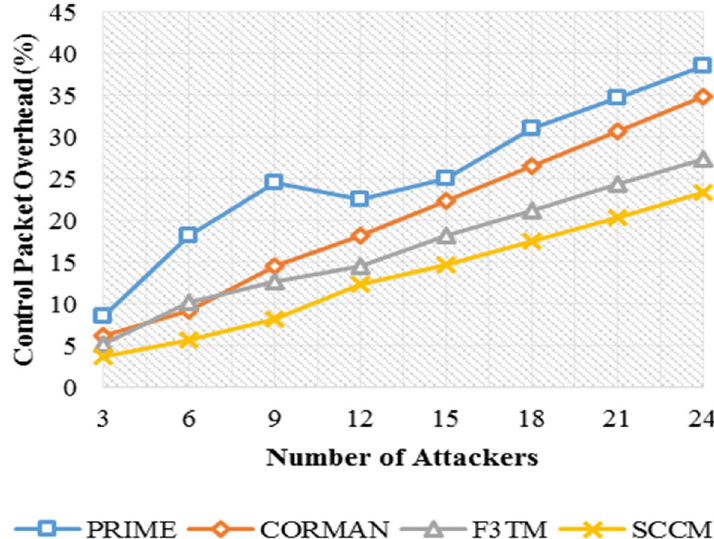
Fig. 7 Control packet overhead vs. attacker